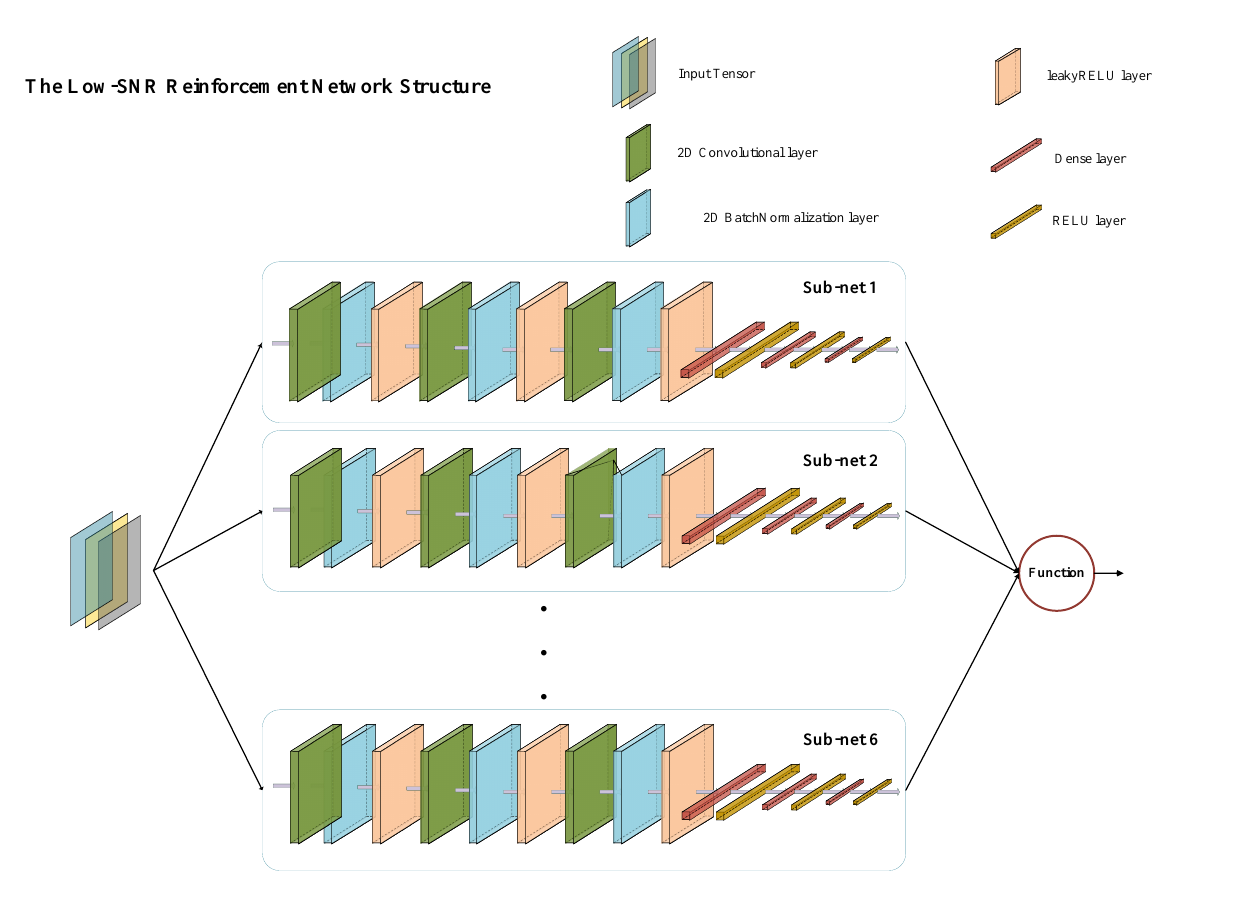
Figure 5. The low-SNR reinforcement network